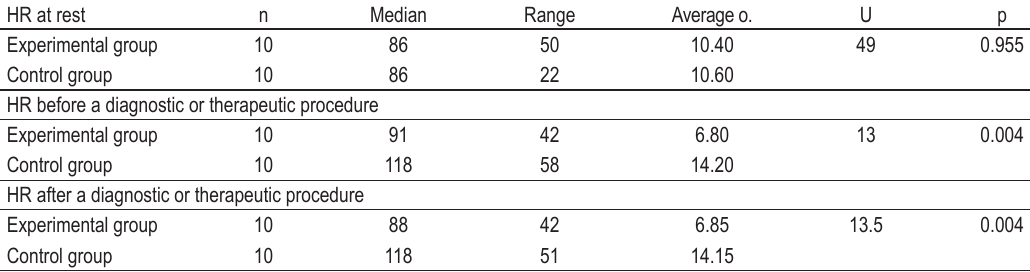
TABLE 1. Heart rate (Mann‑Whitney U)